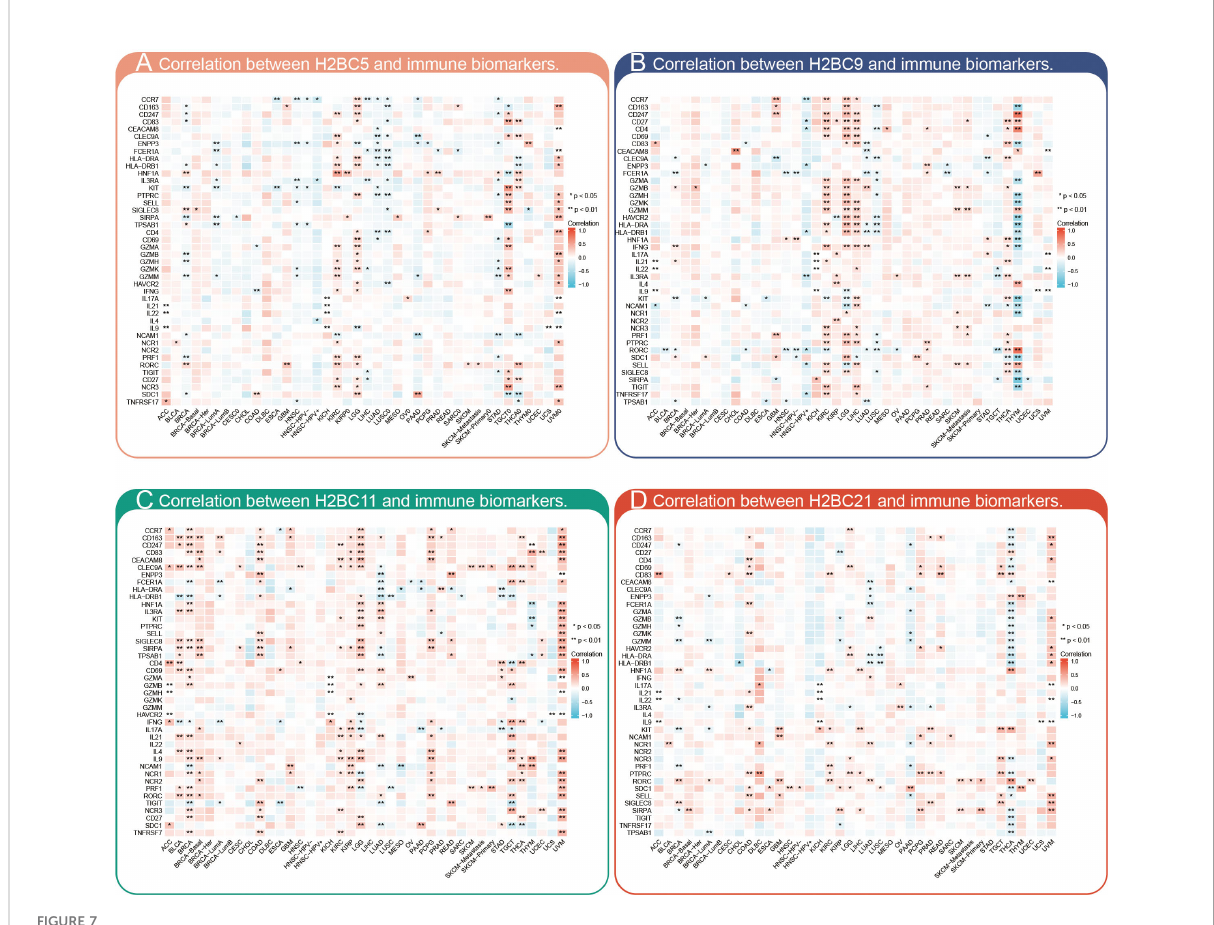
FIGURE 7 Pan-cancer analysis of immune in fi ltration. Pan-cancer analysis of the correlation between (A) H2BC5, (B) H2BC9, (C) H2BC11, and (D) H2BC21 expression and multiple immune cell biomarkers. *P < 0.05, **P <